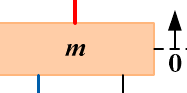
Figure 2. Typical schematic diagram of a passive vibration isolation system.